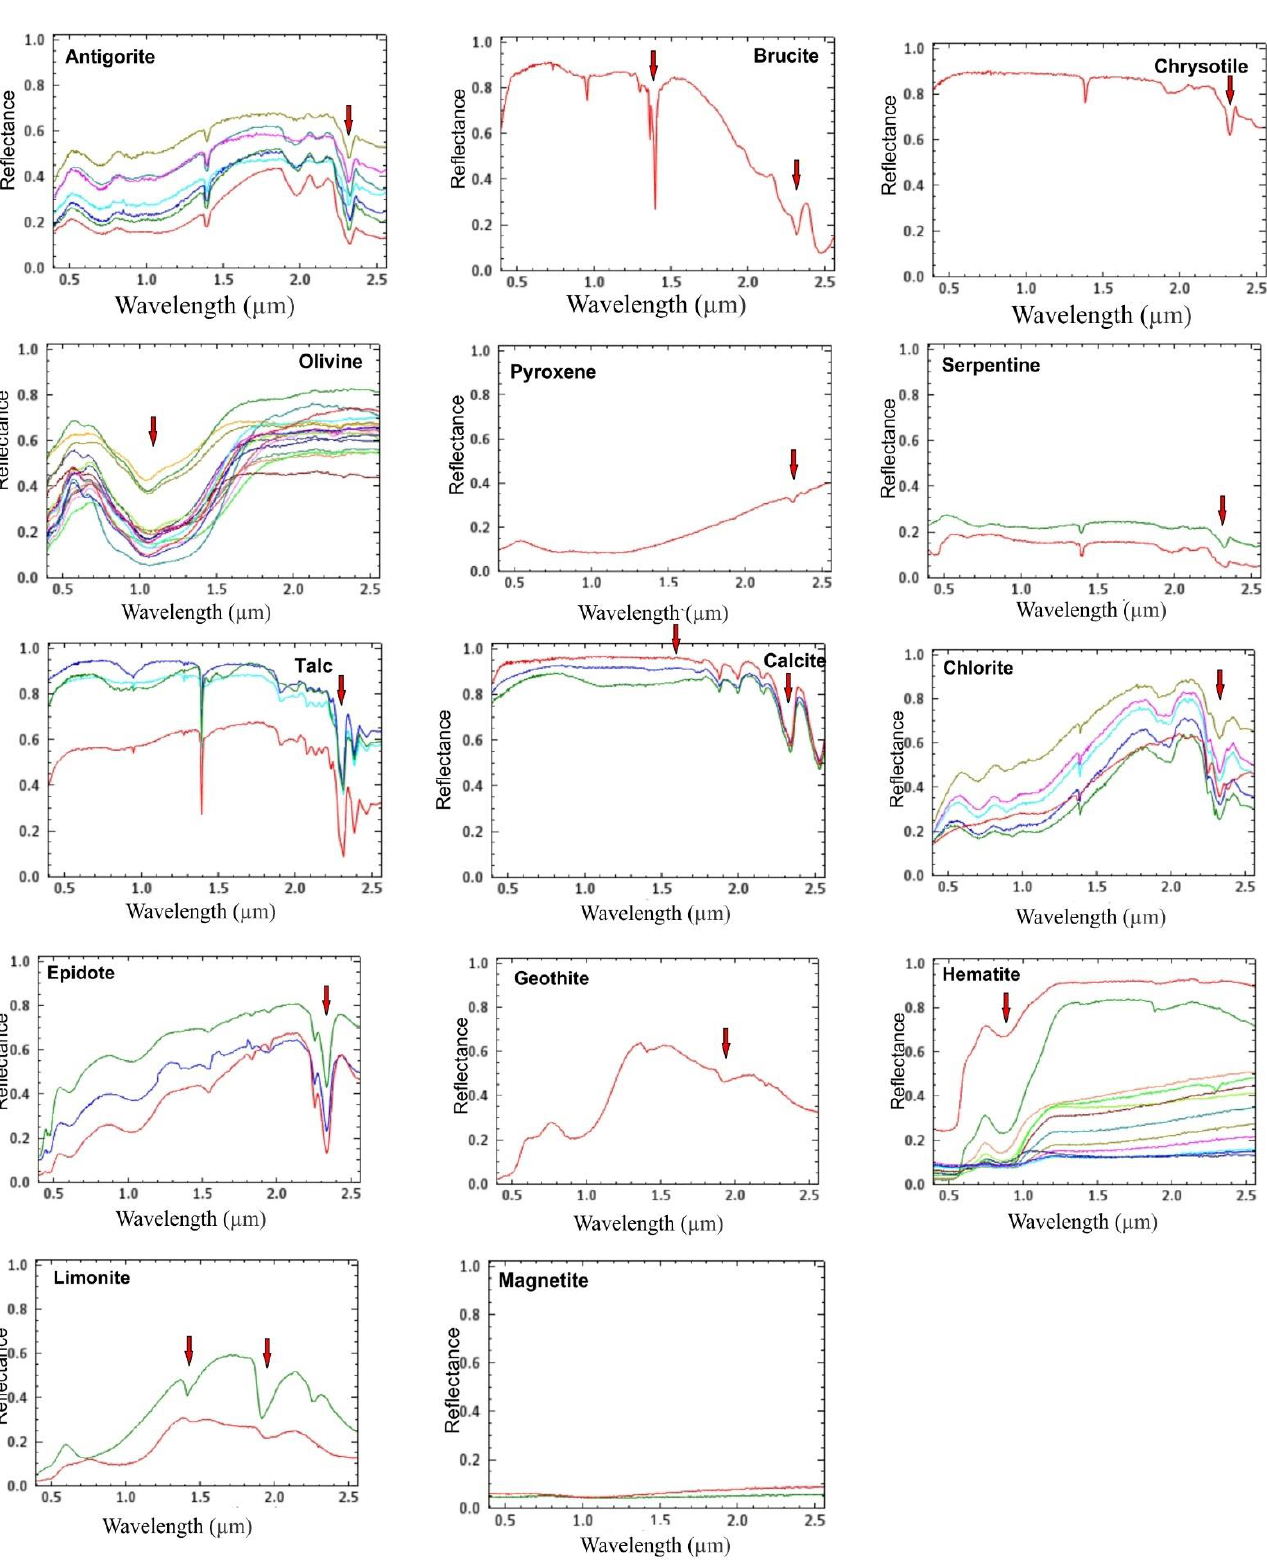
Figure 4. Spectra plot of mafic–ultramafic altered minerals, including iron and carbonate, taken from USGS spectral library within 0.4–2.5 µm portion; the red arrows in plots indicate the absorption feature region.